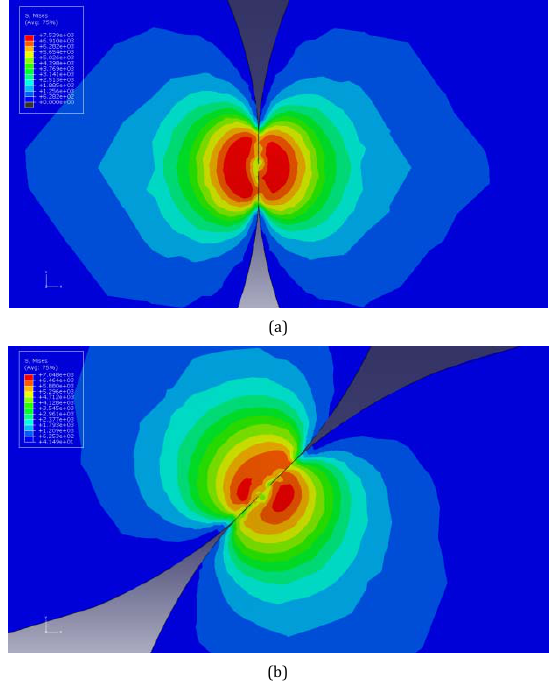
Figure 8. Von Mises stress contours at the contact points for (a) QS and (b) BCC models.